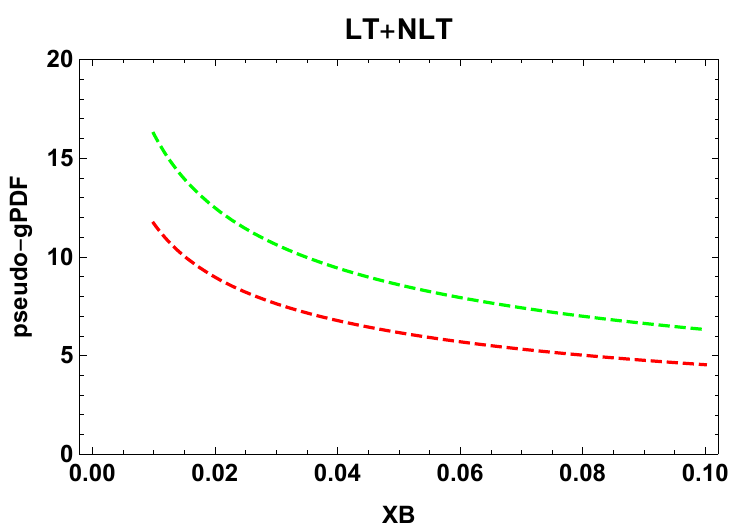
Figure 14 . Comparing the numerical evaluation of eq. (7.5) (red dashed curve) with its approximated analytic result, eq. (D.1) (green dashed